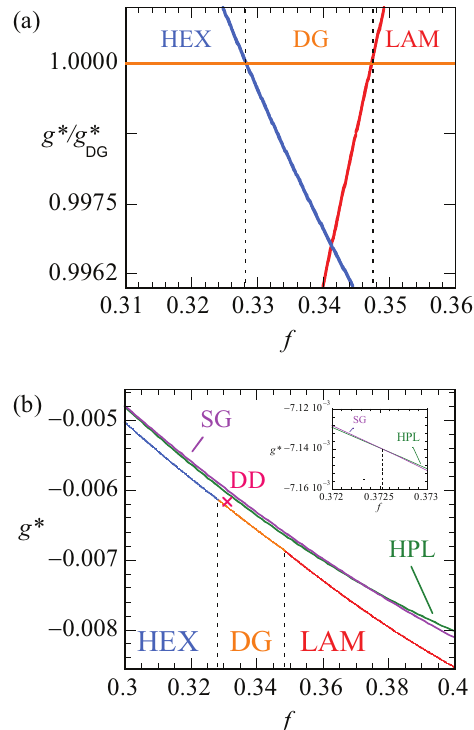
Figure 10. ( a ) Optimized free energy density g ∗ in units of k B T of HEX (blue) and LAM (red) phases divided by the free energy density of DG ( g ∗ / g ∗ ) as a function of composition f for N = 300, DG > 1. First, second and third χ N = 30. Stable phases of HEX and LAM occur when their g ∗ / g ∗ DG regions, separated by dotted lines, represent the HEX, DG and LAM stable regions; ( b ) free energy density ( g ∗ ) of HEX, LAM, DG, DD, SG and HPL phases as a function of composition ( f ) for N = 300, χ N = 30. DD phase is shown in one point only. Only stable regions of HEX, DG and LAM are shown in the graph. The inset gives an expanded view near the crossing point of the HPL and SG free energy densities as a function of f